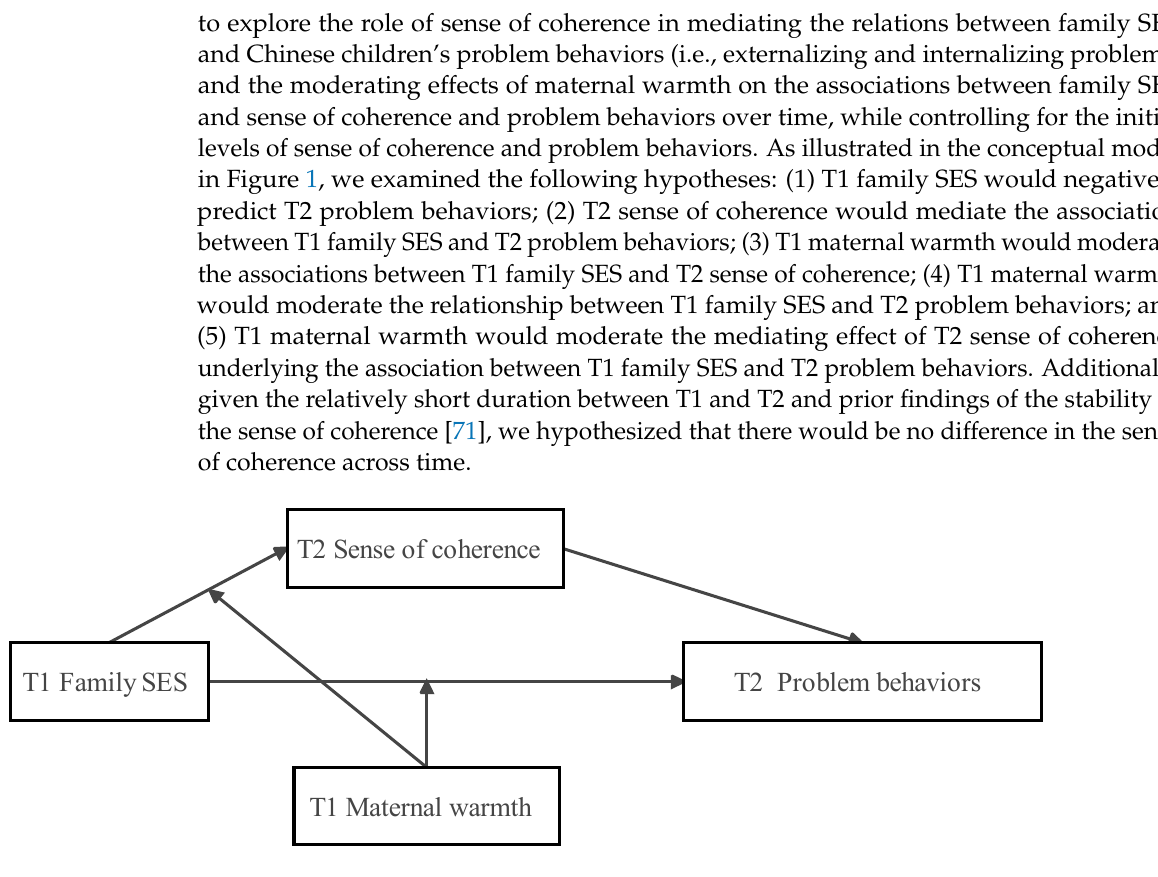
Figure 1. The Moderated Mediation Model. Note. T1 = Time 1; T2 = Time